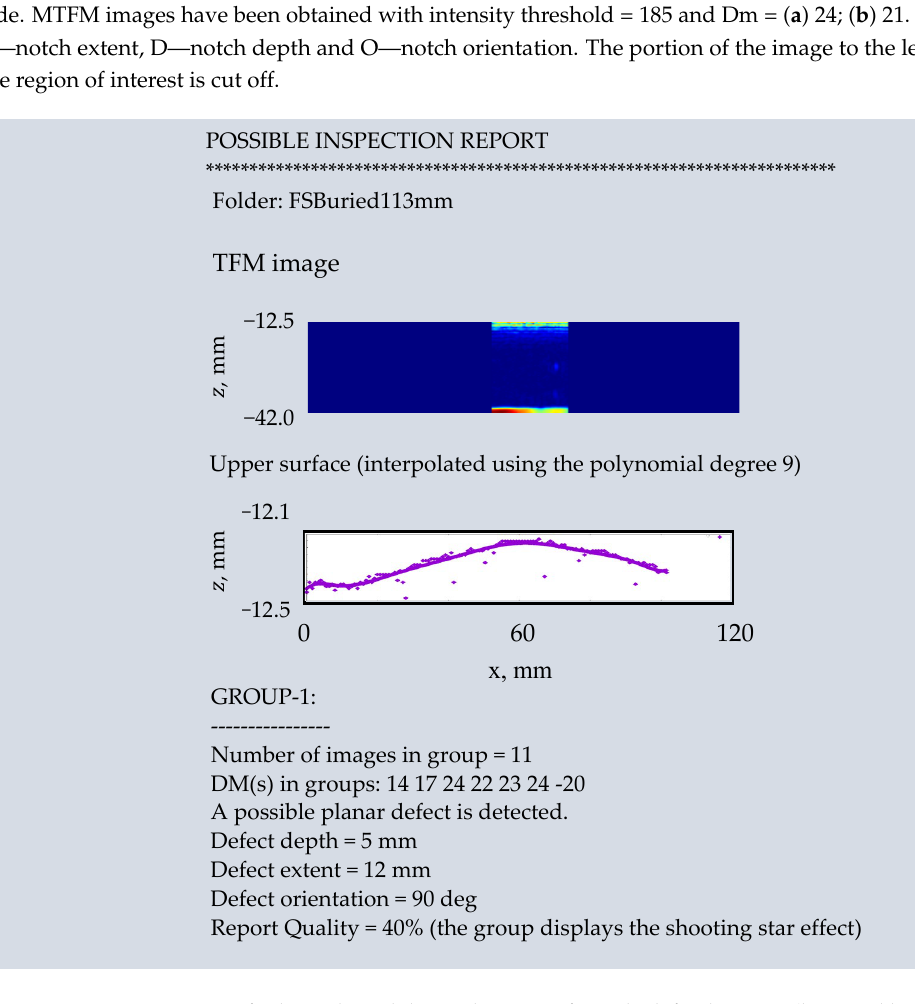
Figure 8. Inspection report for buried notch located 113 mm from the left edge. Key (here and below): dots–surface points acquired by SurfaceProfiling; line interpo lating